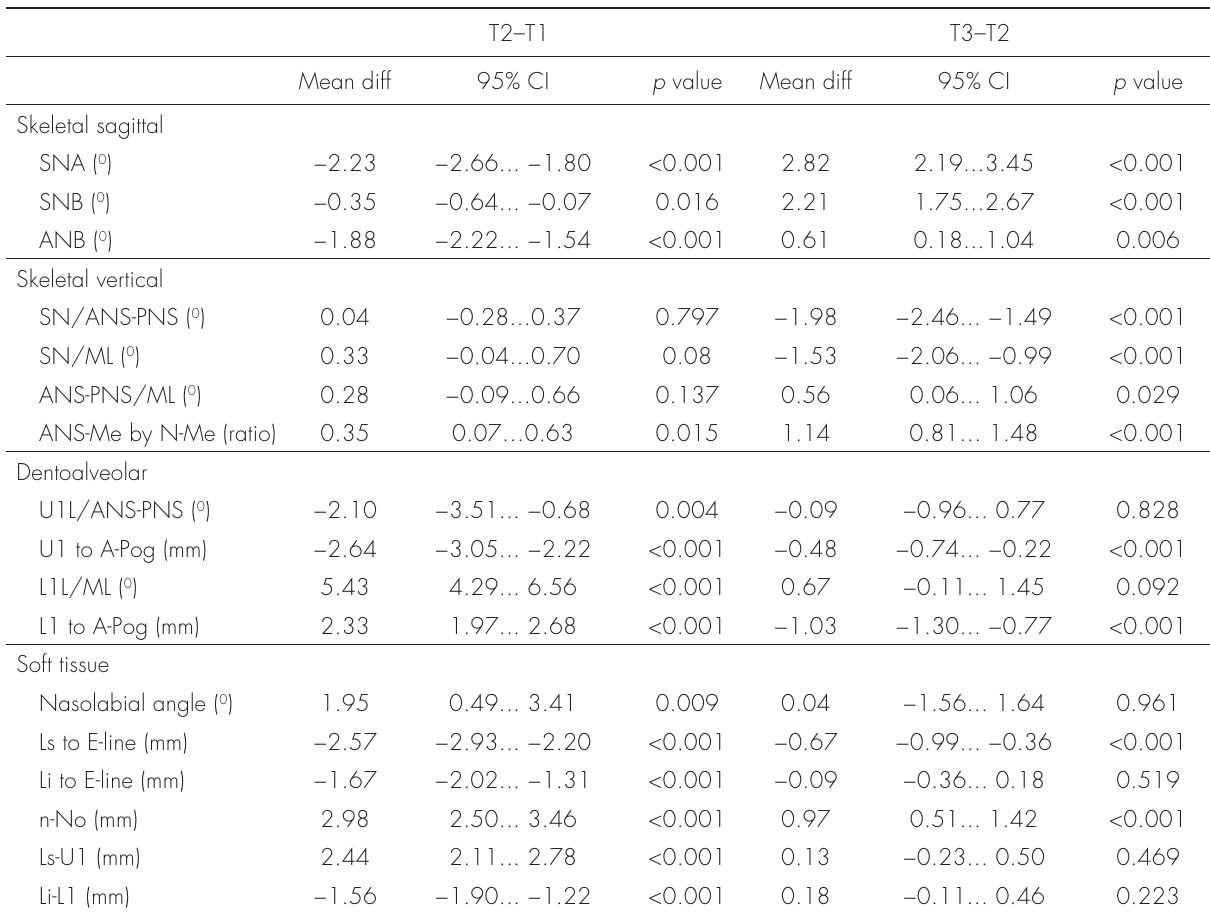
Table IV. Mean increments of the cephalometric variables and 95% confidence intervals (95% CI) for the two different time periods (T2–T1 and